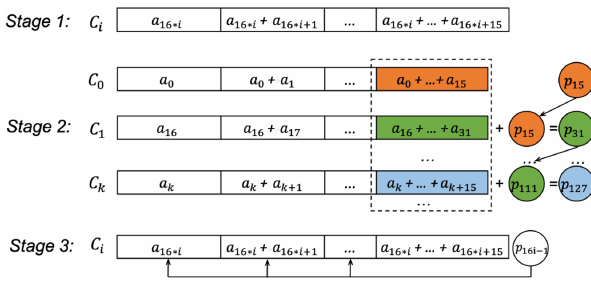
Figure 8. Register-communication-based parallelization of depen- dent loops: an example of computing the geopotential height at 128 different layers, which is parallelized as eight CPE